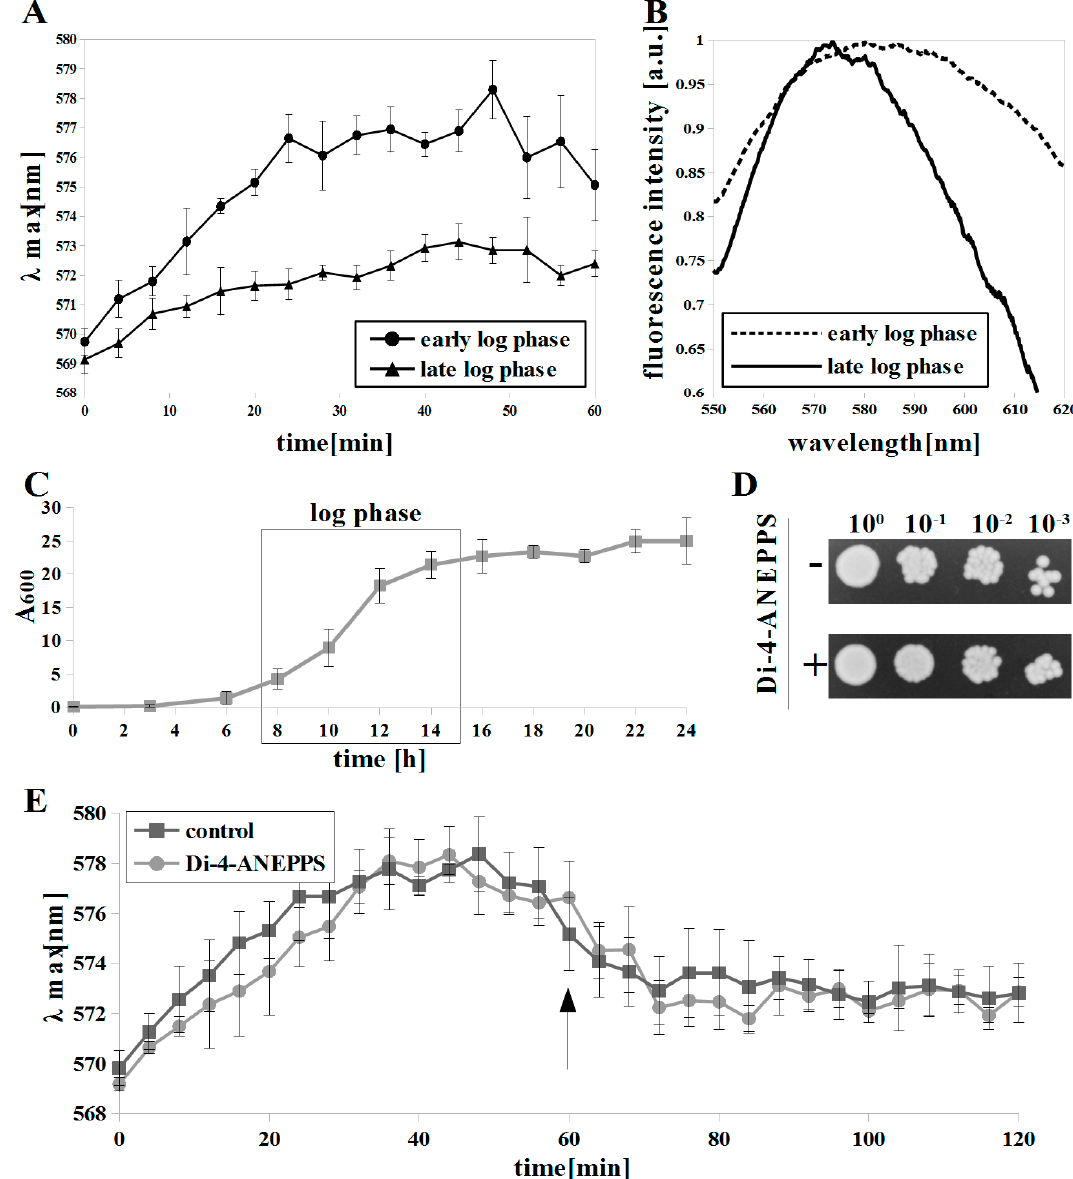
Figure 1. Growth phase-dependent depolarization of C. albicans cells measured by: ( A ) monitoring fluorescence maxima in time by diS-C 3 (3), means ±SD (n = 4) and ( B ) fluorescence spectrum shift of di-4-ANEPPS (red-blue signal ratio (R-B) values = 1.043 ± 0.011 and 0.921 ± 0.002 for 8 h and 14 h, respectively), each spectrum is averaged (n = 9); ( C ) growth curve of C. albicans CAF2-1, strain was grown to 8 h and 14 h (early and late log phases), means ±SD (n = 3); ( D ) di-4-ANEPPS was not toxic towards C. albicans CAF2-1; ( E ) ATP-binding cassettes (ABC) mediated diS-C 3 (3) efflux was not inhibited by addition ( arrow ) of di-4-ANEPPS, means ±SD (n = 4).